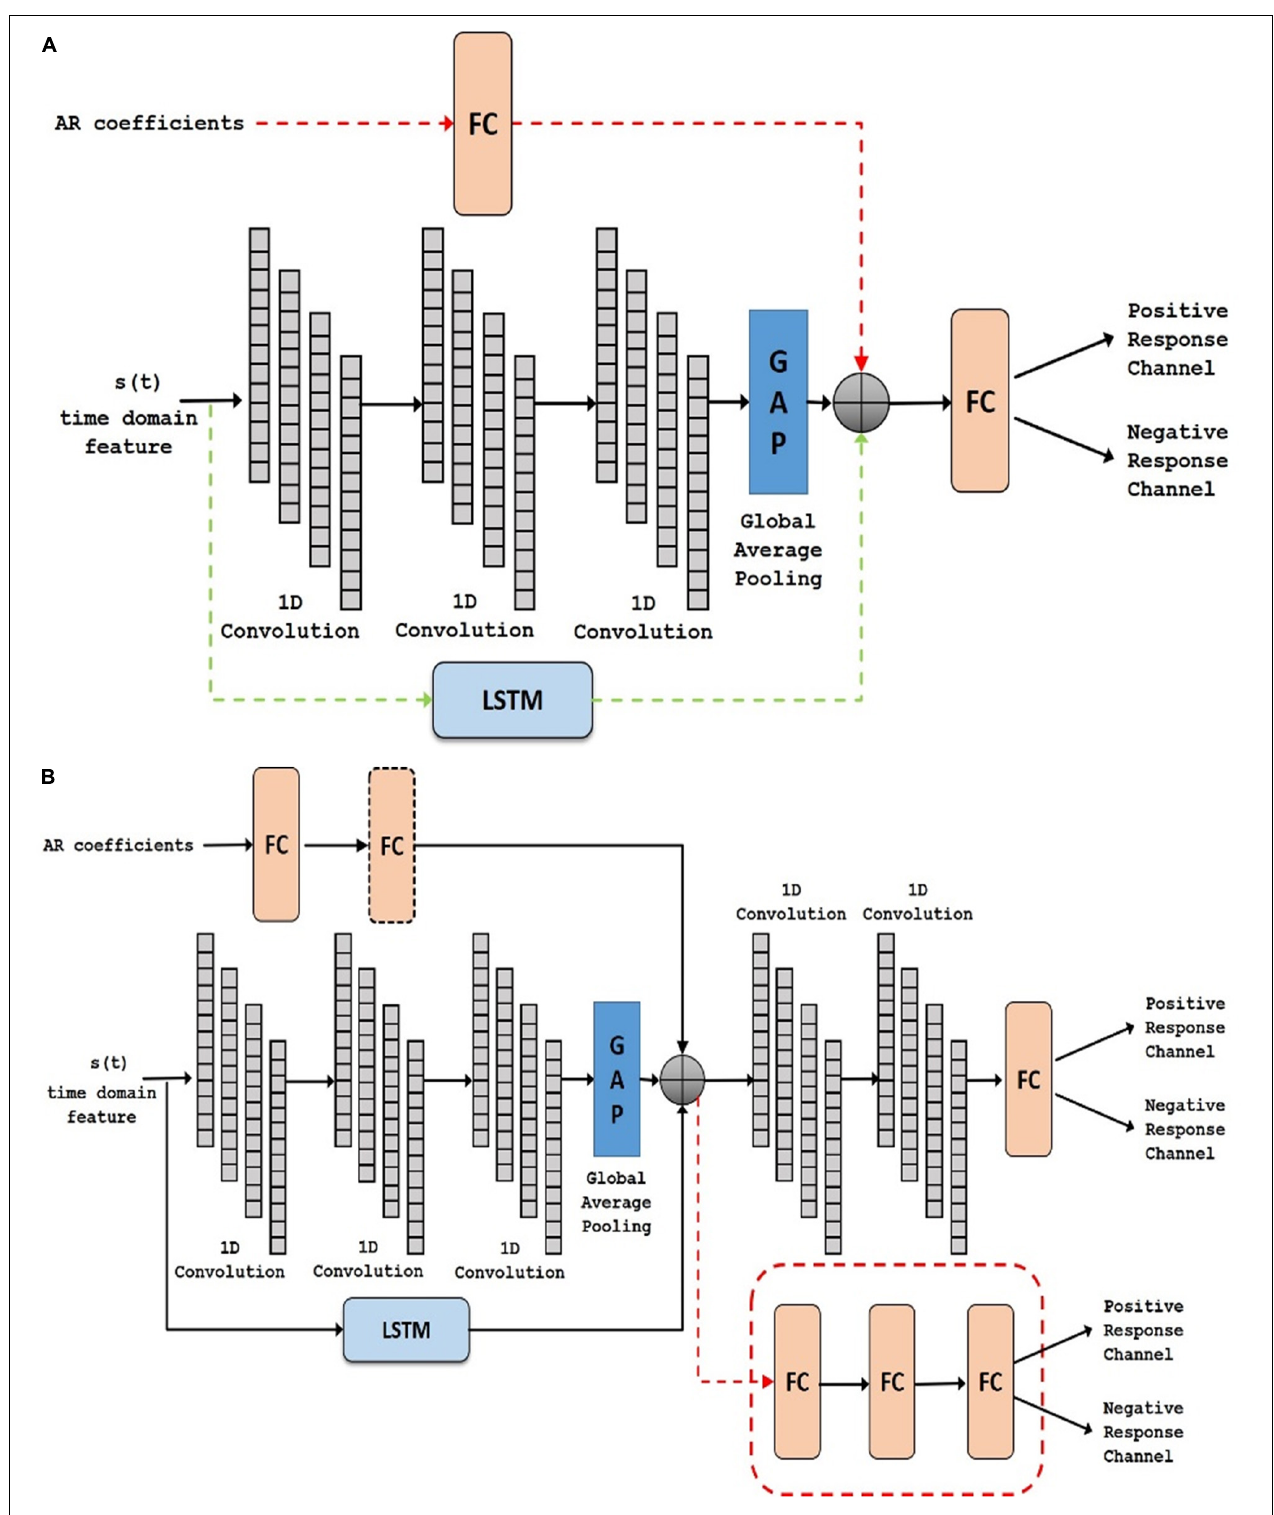
FIGURE 6 | Deep network structure of (A) AT 1 , AT 2 (with added dotted green) and AT-AR 1 (with added dotted red and green) and (B) AT-AR 2 , AT-AR 3 (replace fusion model with the dotted red model) and AT-AR 4 [with added fully connected (FC) layers in dotted box]. AT, Active Time; AR, Auto Regressive; LSTM, Long Short Term